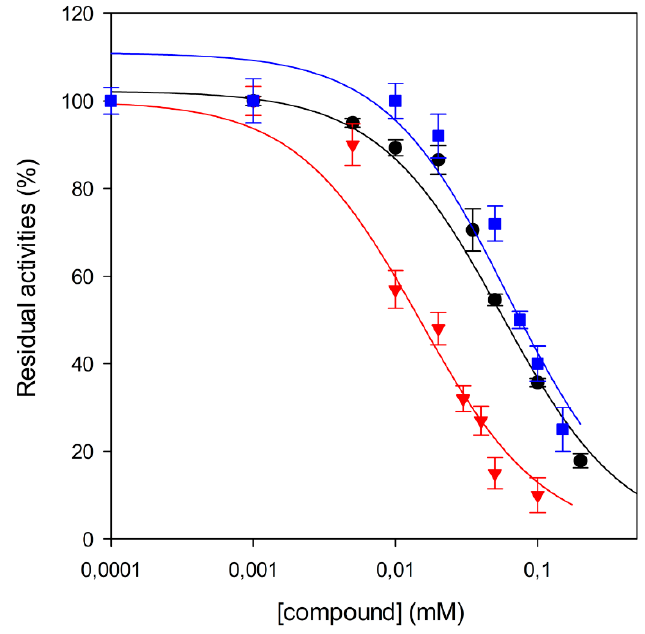
Figure 1. Effects of 1 ( ) and 2 ( ) against MbtI enzyme activity compared with I ( ▼ ). IC 50 values were determined by assaying the enzyme at subsaturating concentrations of chorismic acid (50 μ M).